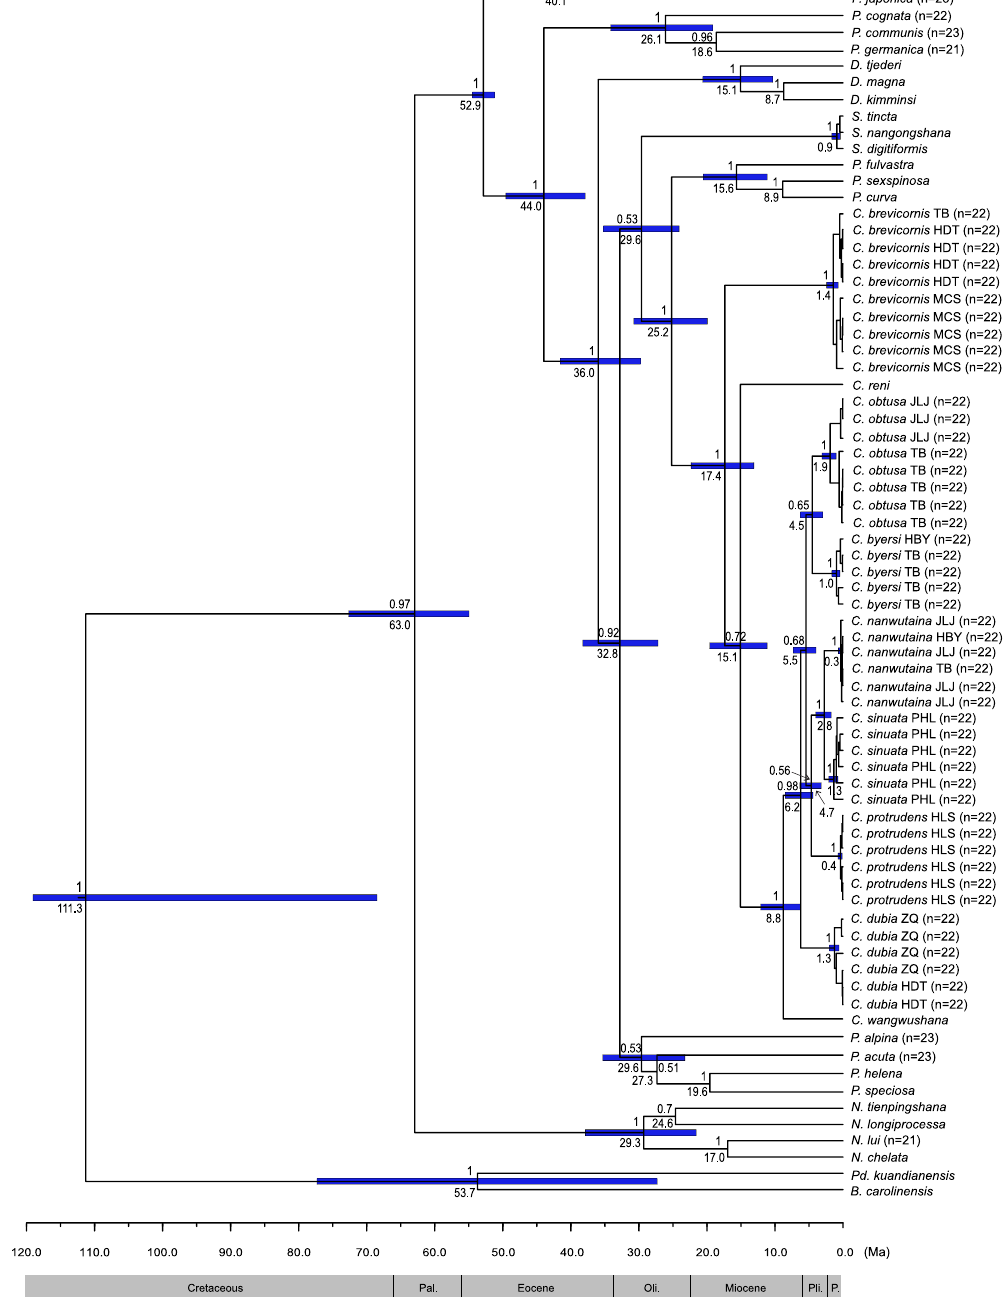
Figure 3. Bayesian maximum-clade-credibility tree based on the concatenated dataset (28S rRNA, cox1 and cox2 ) in BEAST 1.8.4 with a relaxed clock and Yule speciation process. Node numbers above blue bars show Bayesian posterior probabilities (PP); node numbers below blue bars indicate the mean estimated divergence times of Panorpidae in million years ago (Ma). Horizontal blue bars at nodes represent 95% highest posterior density date ranges. Pal., Paleocene; Oli., Oligocene; Pli., Pliocene; P.,